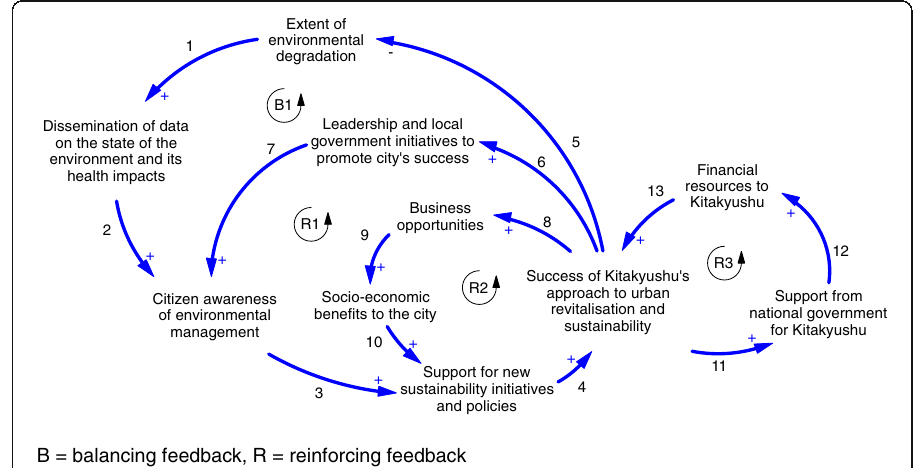
Fig. 1 Systems diagram of Kitakyushu ’ s sustainability experimentation. See Table 4 below for